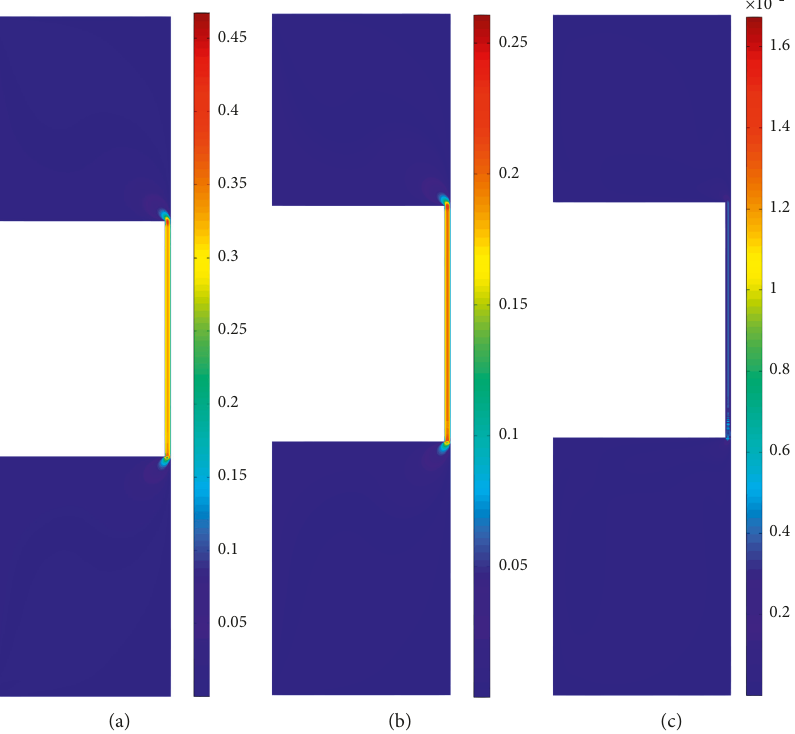
Figure 15: Magnitude of flow velocity (m/s) in the MR damper under sinusoidal displacement excitations of 1.27cm, 0.2Hz, 2A: (a) t � T / 12; (b) t � 2 T /12; (c) t � 3 T